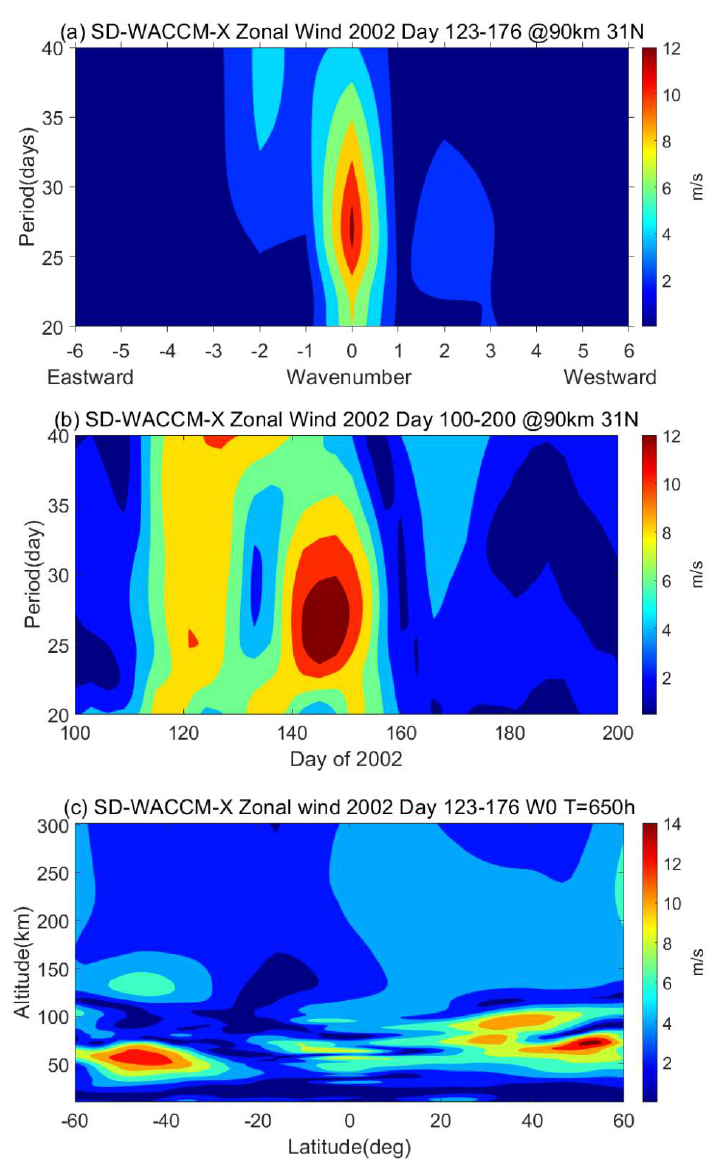
Figure 10. ( a , b ) The period–wavenumber power spectra (the period–time power spectra) of zonal wind at 90 km height during day 100–200, 2002. ( c ) The spatial structure of the 27-day oscillations in the zonal wind with wavenumber 0. The spatial structure of the quasi-27-day oscillation in atmospheric zonal wind is shown in Figure 10c. The result indicates that the oscillation is present throughout the northern hemisphere at 10–300 km. The wave amplitudes reach a peak above 70–90 km at 30°N–80°N latitude, and relatively weak oscillations occur in the thermosphere. The weaker oscillations in the thermosphere indicate that this quasi-27-day oscillation is not